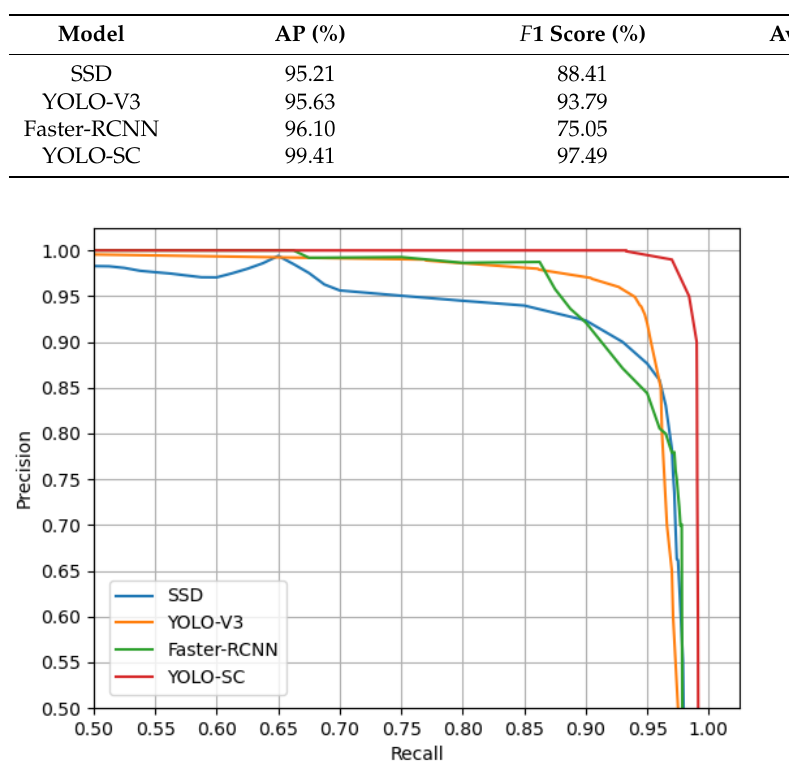
Figure 13. Precision–recall curves of different